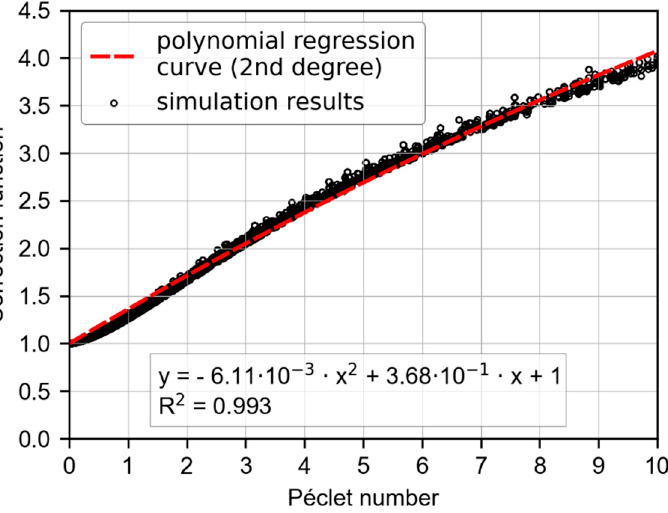
Figure 7. Second-degree polynomial correction function for the infinite MLS for steady-state condi- tions.